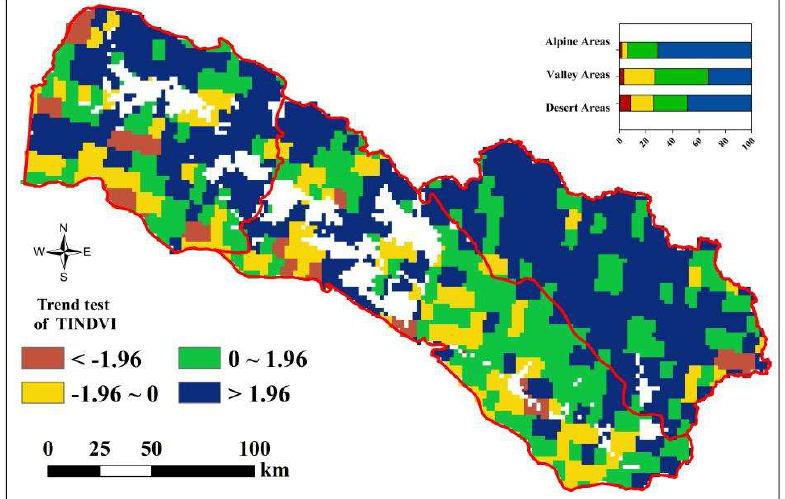
Figure 4. Spatial distribution of trend test value of TINDVI. Note: The histogram in the plot showed the proportion of areas with significant (| Z C | > 1.96, p < 0.05) and non-significant (| Z C | < 1.96, p < 0.01) changes.